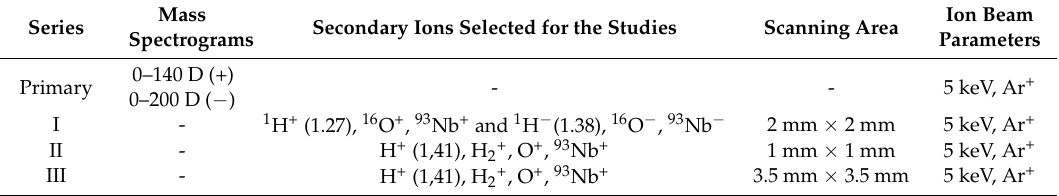
Table 1. Parameters used in the Secondary Ion Mass Spectrometry (SIMS)